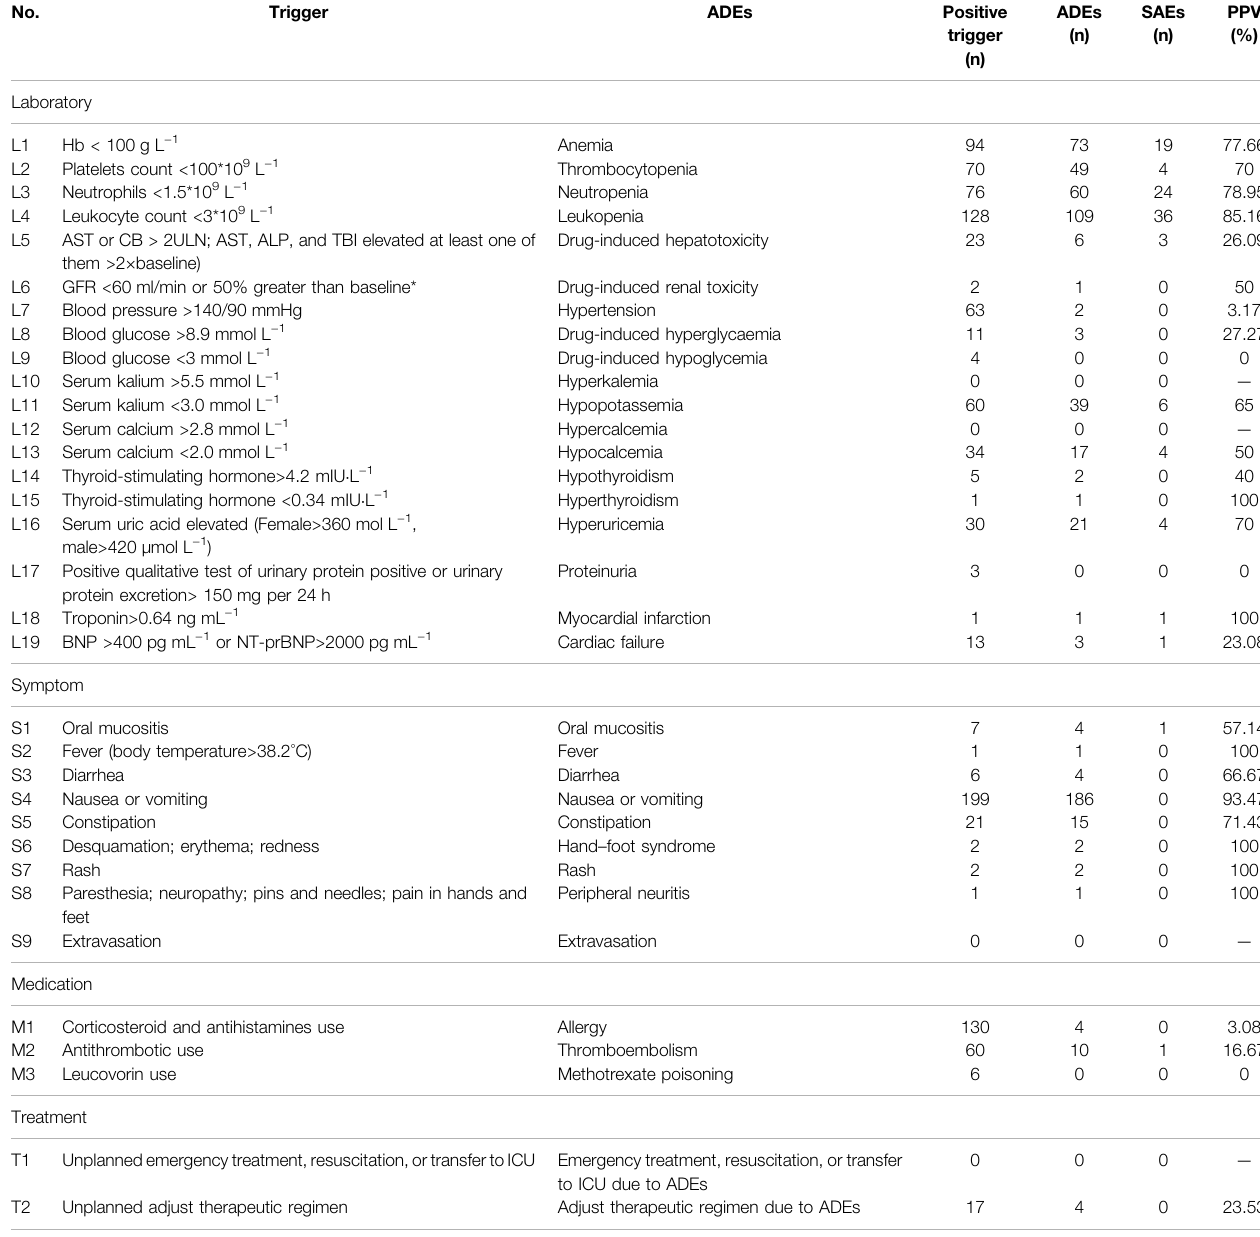
TABLE 1 | Trigger items and their